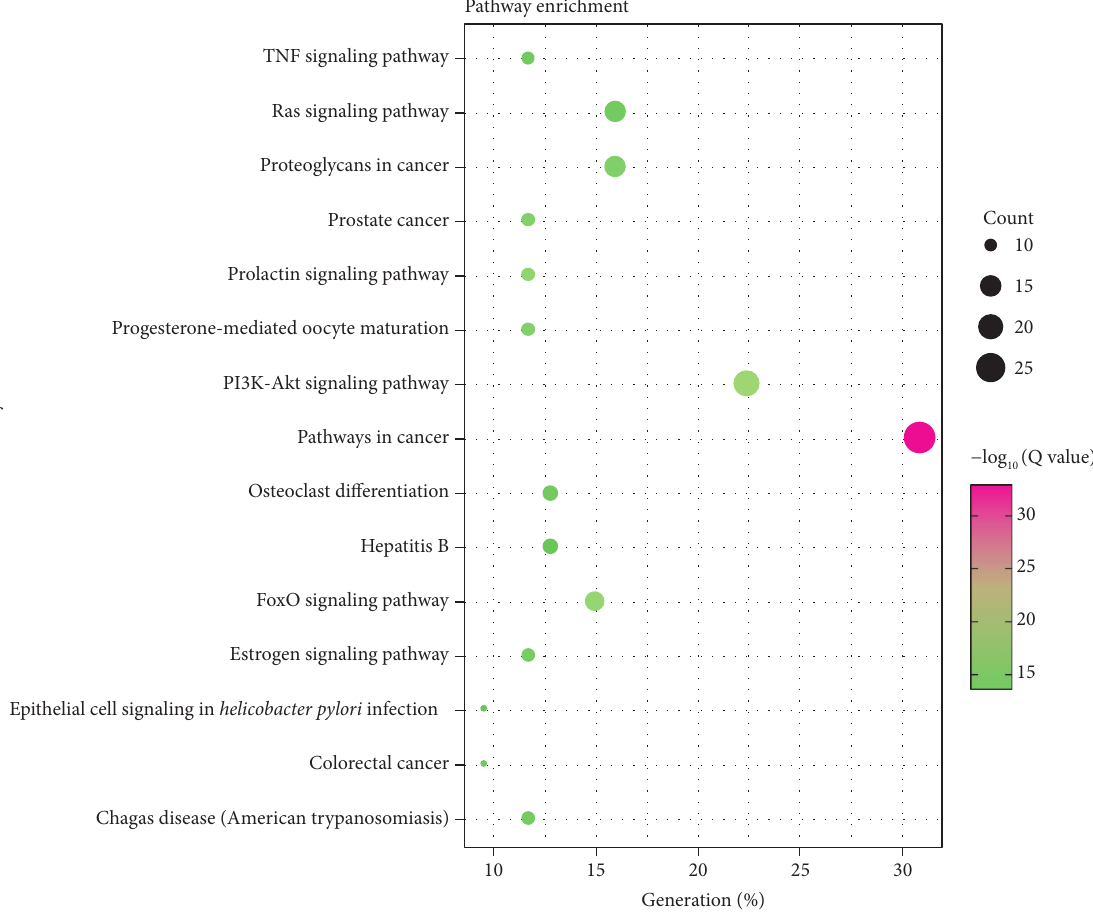
Figure 8: KEGG bubble